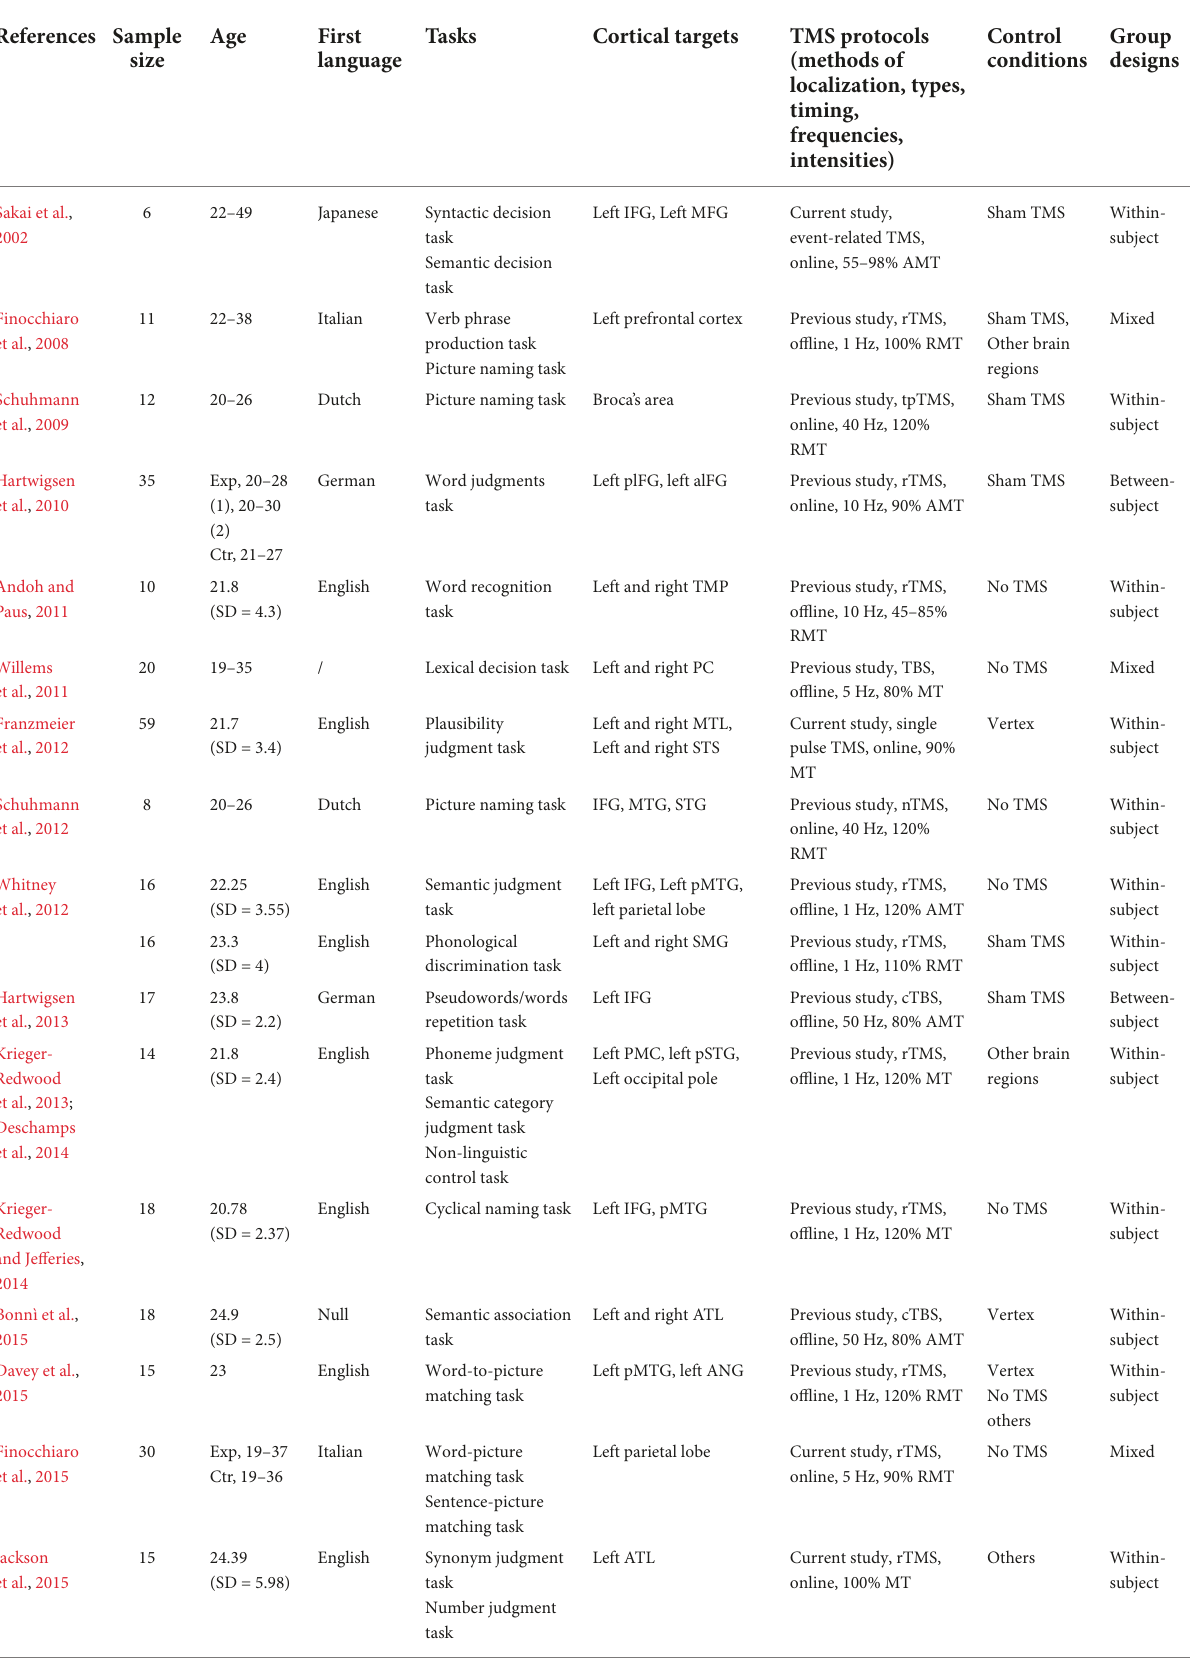
TABLE 1 Overview of the studies included in the